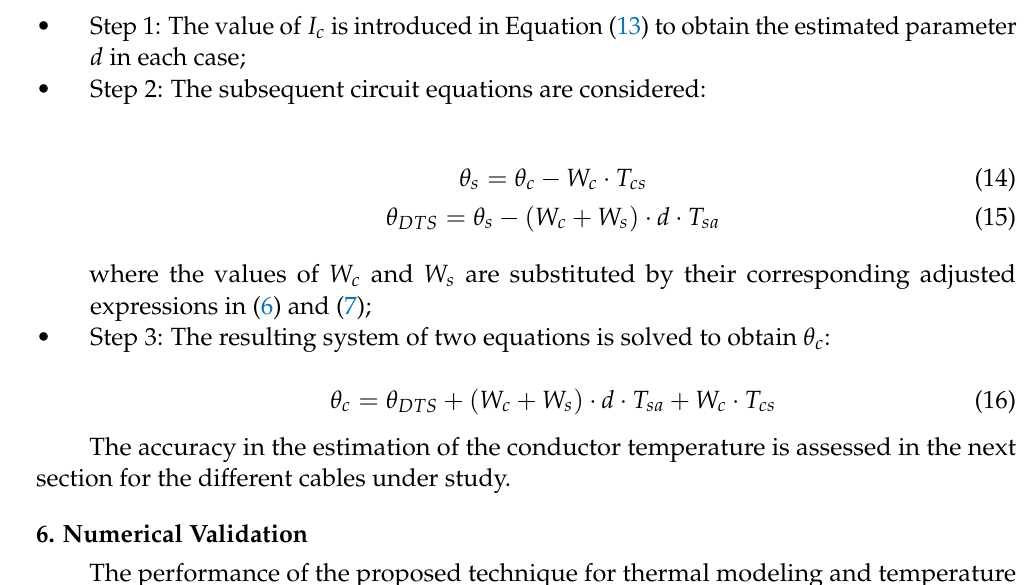
Figure 17. Reduced electrical circuit for the calculation of θ c .